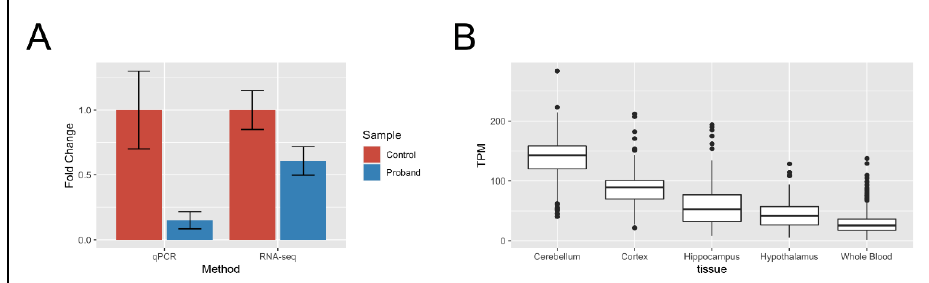
Figure 2. Downregulation and expression of MINK1. ( A ) Expression data from qPCR and RNA-Seq showed the downregulation of MINK1 in the proband NESCs compared to healthy control individuals. ( B ) Expression data of MINK1 in healthy individuals, as seen in GTEx, showed that the gene is higher expressed in neural tissue compared to blood, which highlights the importance of appropriate RNA sampling for relating transcriptomic analysis to clinical data. TPM, transcripts per million.